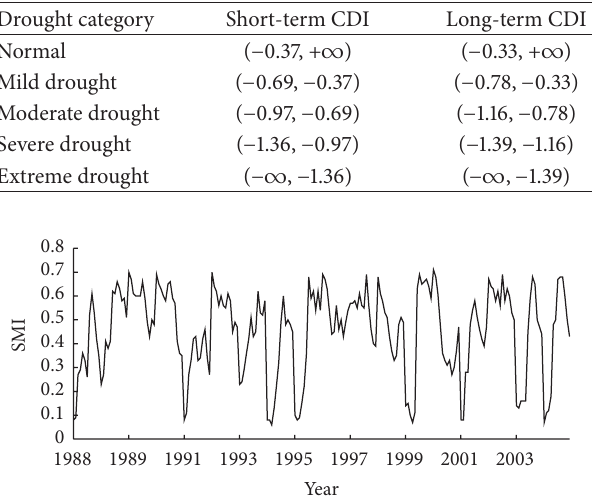
Figure 2: Temporal variations of the SMI in the upper Huaihe River basin.